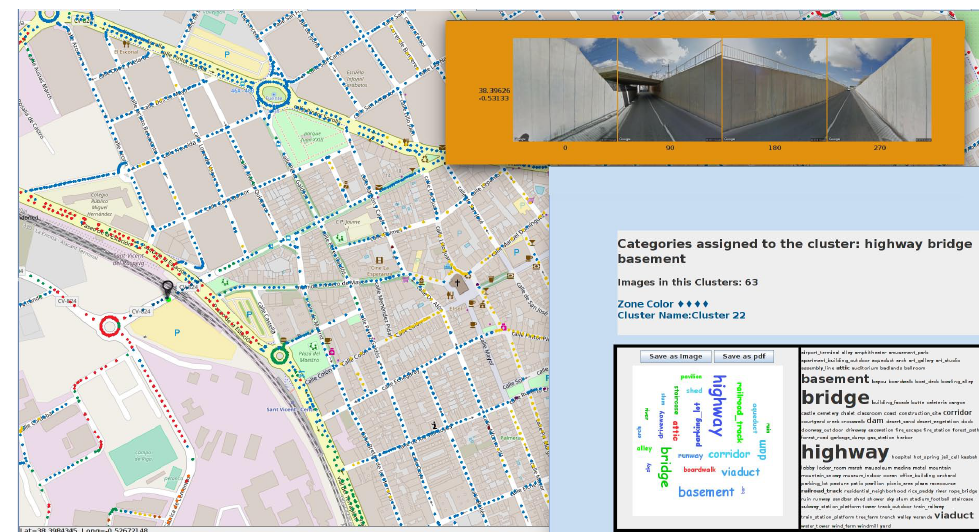
Figure 13. Details of the map generated for a specific point on the map.